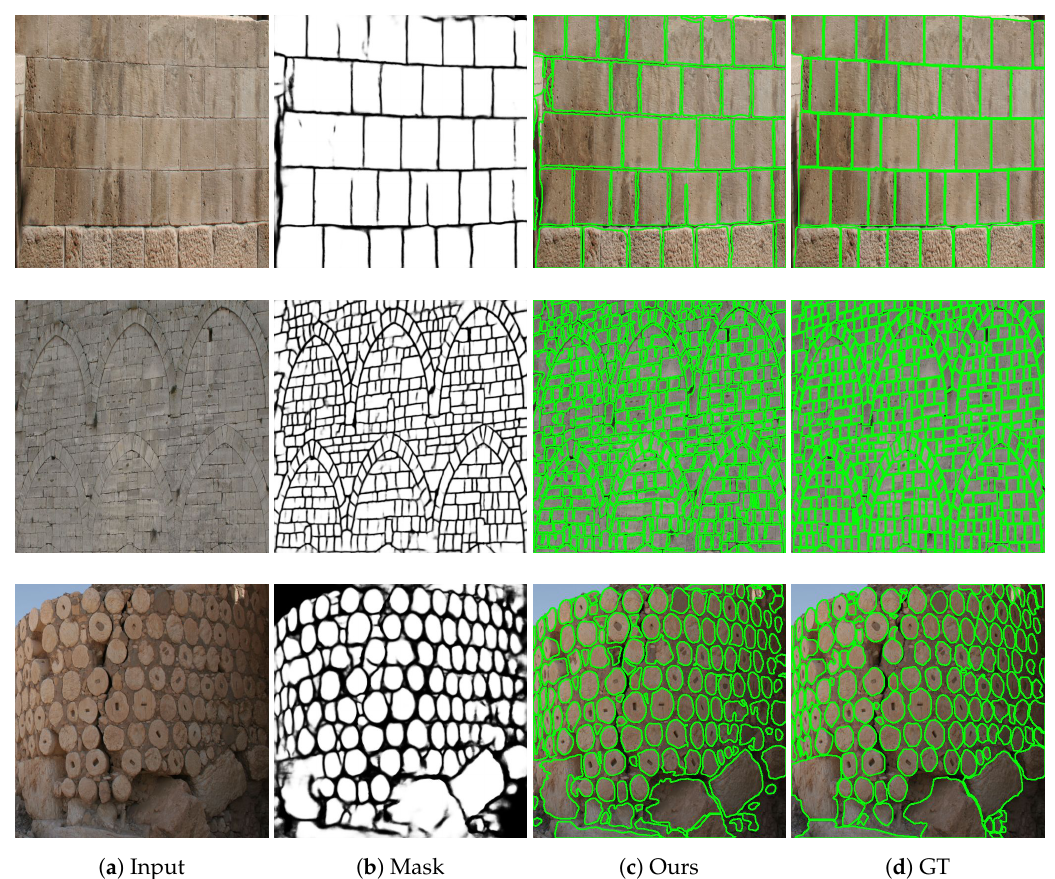
Figure 13. Results of the brick segmentation step of the proposed algorithm on real scenes for ancient walls in